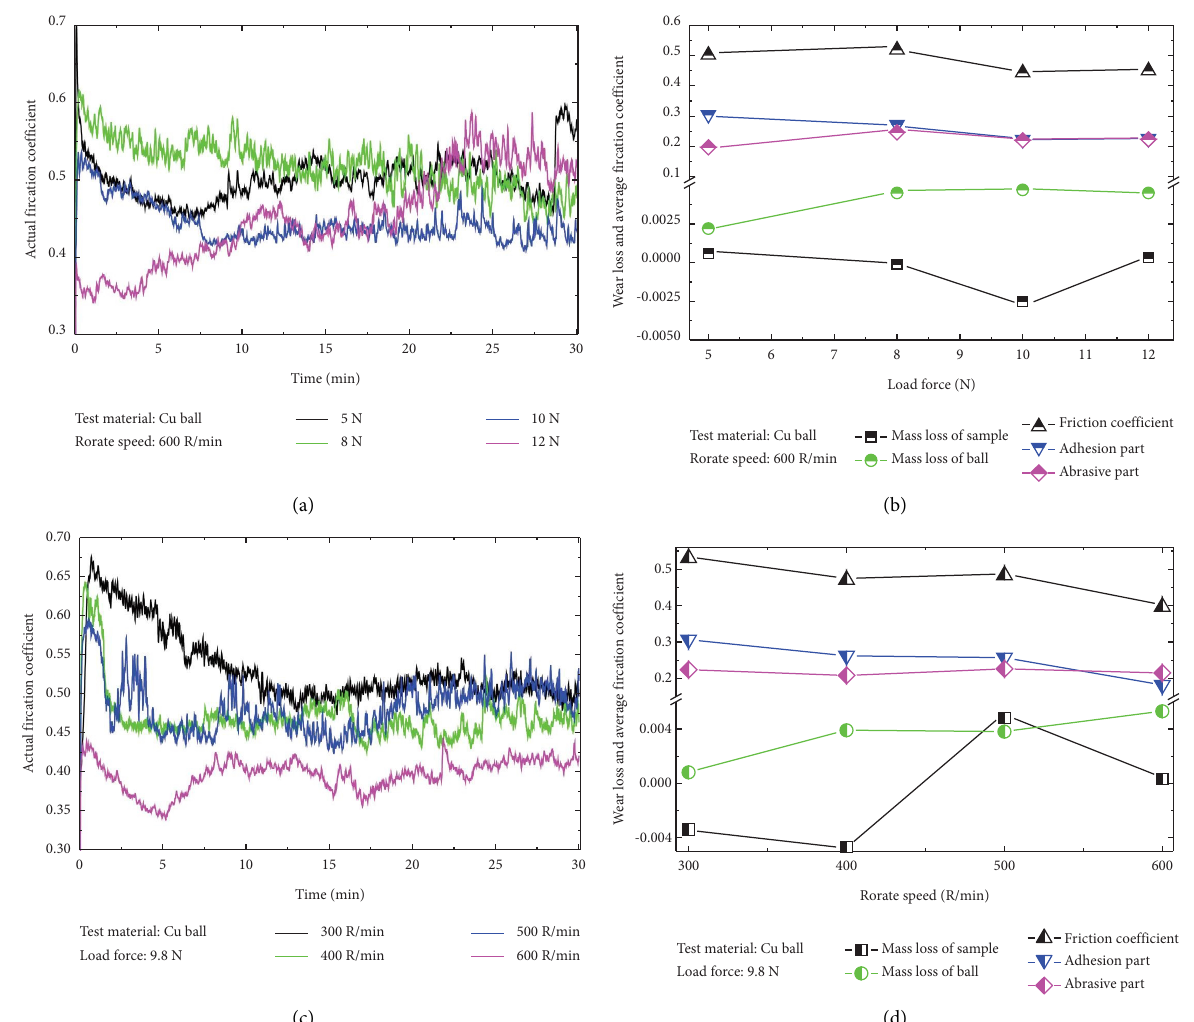
Figure 13: COF (a) and mass loss (b) of the composites with Cu pair under 5–12N; COF (c) and mass loss (d) of the composites at